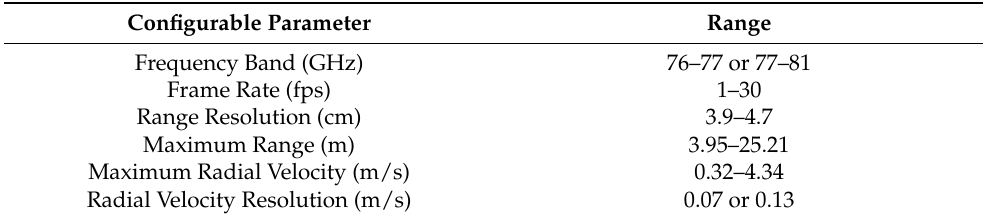
Table 1. Radar EVM AWR1843BOOST configurable